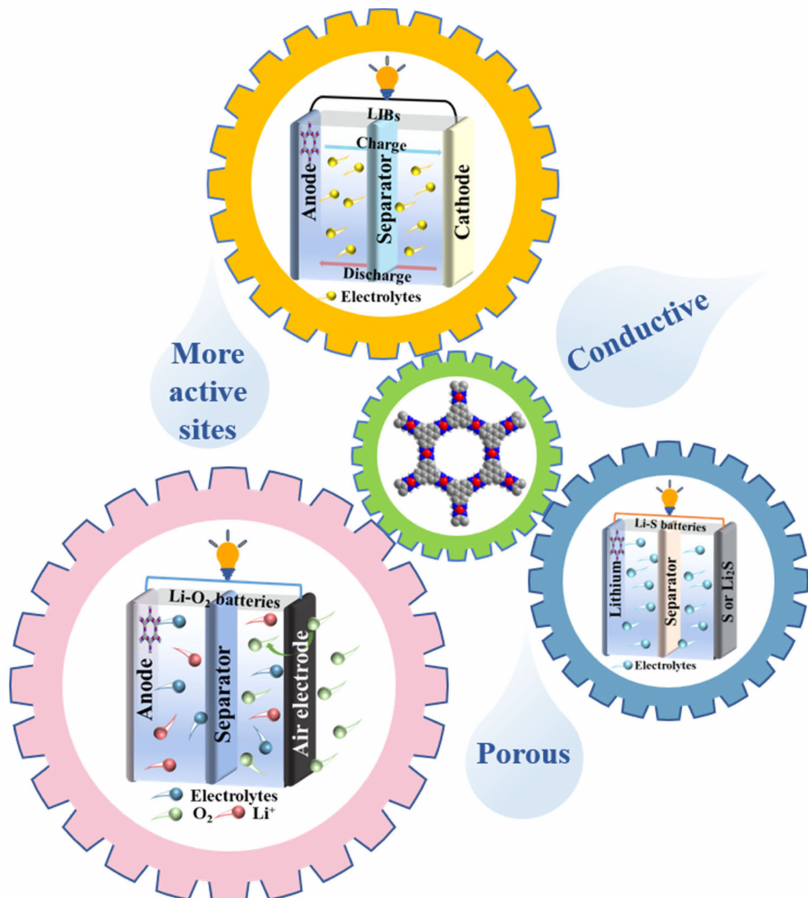
Figure 2. Application of c-MOFs in rechargeable lithium batteries.